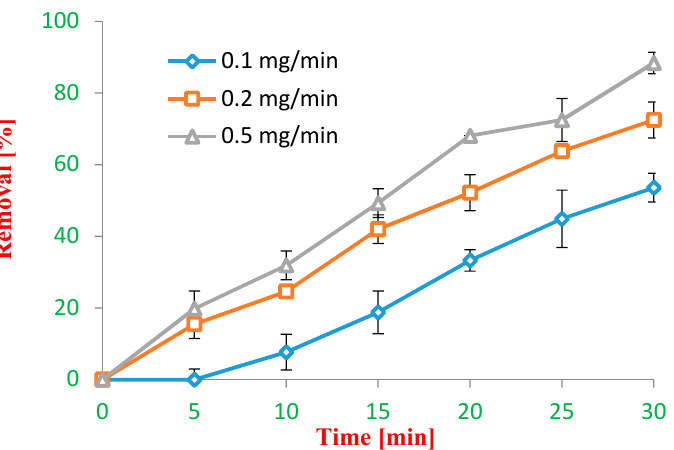
Figure 11. Ozone dose effect in arsenic removal studies (ozone dose = 0.5 mg/min, As = 68 ± 8 ppb, 0.1mg/min. 0.2 and 0.5 mg/min, pH = 8.2 ± 0.3, Fe-ZA = 10 g/L, volume = 1 L, time = 30 min, T = 33 ± 2 °C).